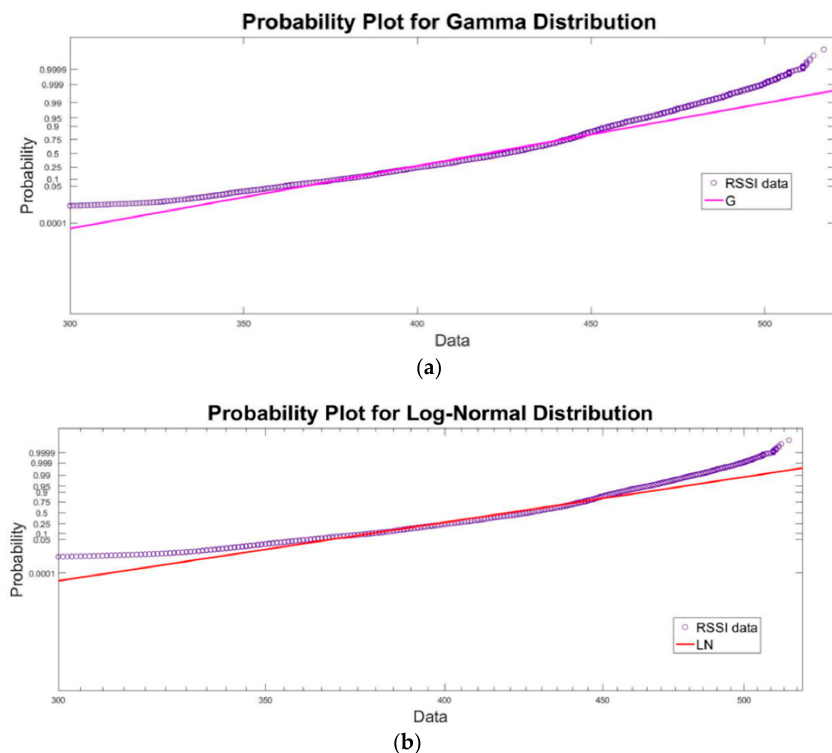
Figure 5. Probability plots for ( a ) Gamma and ( b ) Log-Normal distribution against RSSI data.